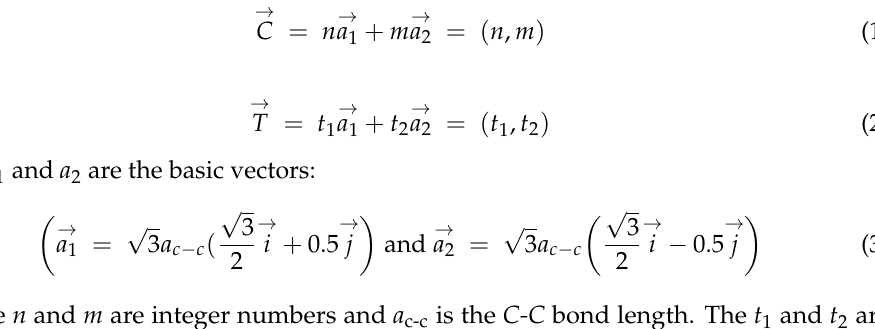
Figure 2. The proposed model.